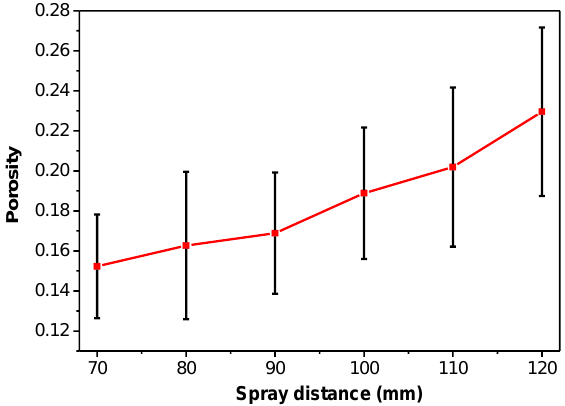
Figure 6. Porosity at different spray distances.